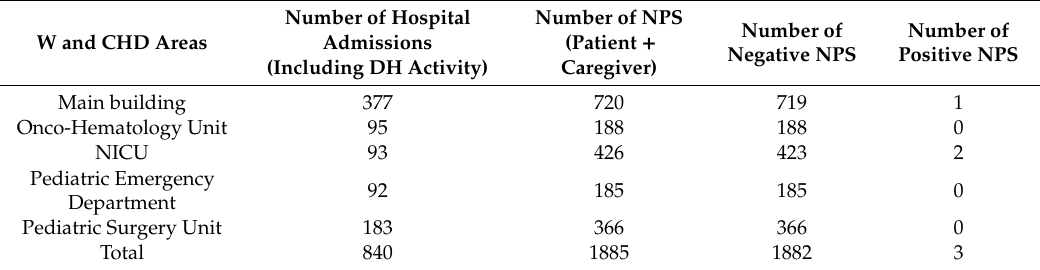
NPS Surveillance in Children and Their Caregivers for Non-Deferrable or Urgent Hospital